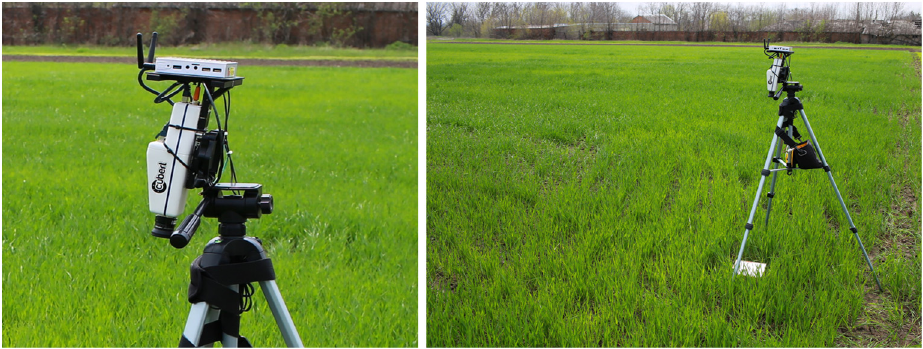
Figure 2. Photo of the studied plant species in the field. Educational and experimental farm “Nedvigovka” of the Southern Federal University, Rostov-on-Don, Russia. The spectral characteristics of the selected objects were studied using a Cubert UHD185 frame hyperspectral camera [32,33] (Figure 3 and Table 1).